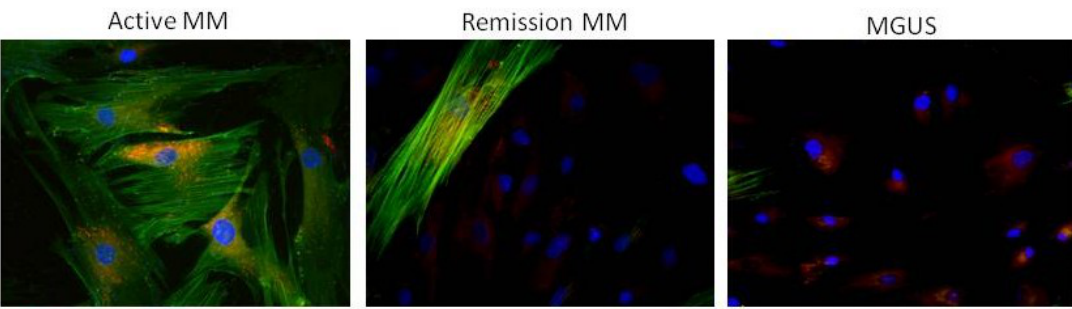
Figure 2. Immunofluorescence staining of purified bone marrow CAFs with αSma (green) and FSP1 (red) in representative MM patients and the benign monoclonal gammopathy (MGUS) patients. Cell nuclei stained with DAPI. Original magnifications